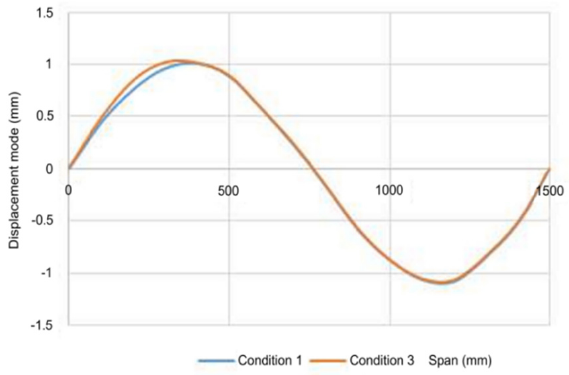
( a ) Comparison of the first-order vibration modes under Conditions 1 and 3.